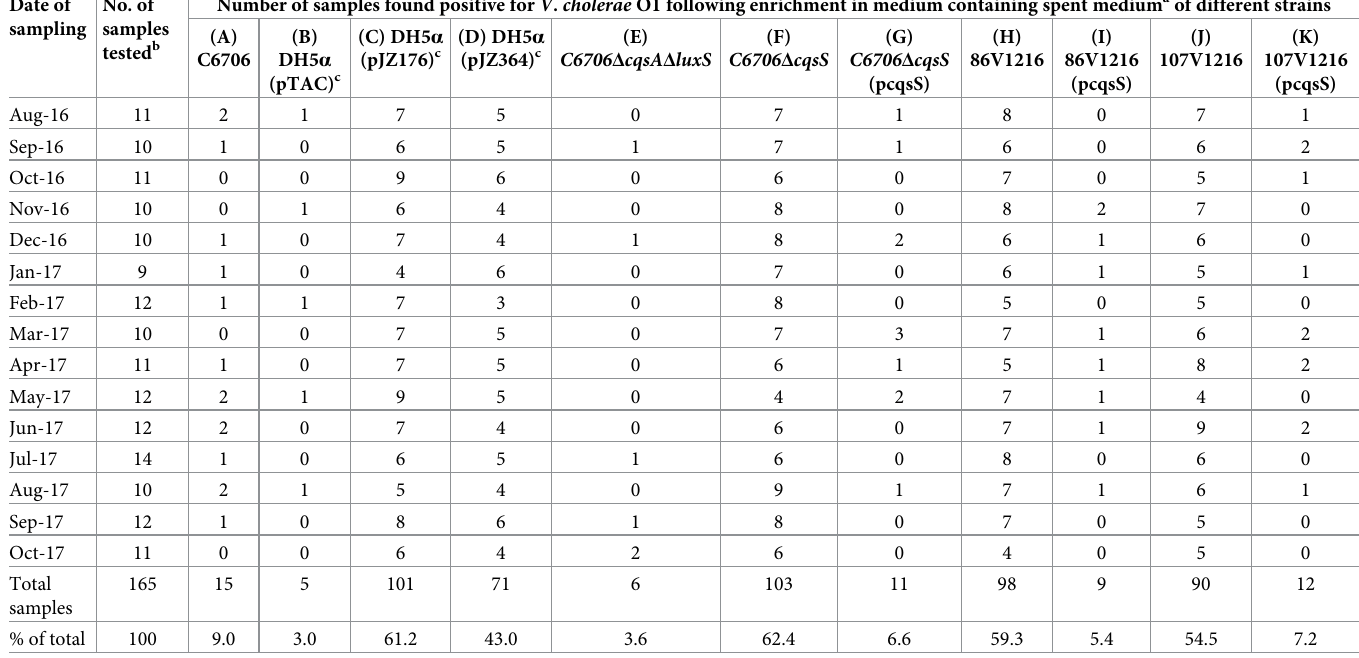
Table 2. Recovery of Vibrio cholerae O1 CVEC in water samples by culturing under different conditions. Date of No. of sampling samples tested